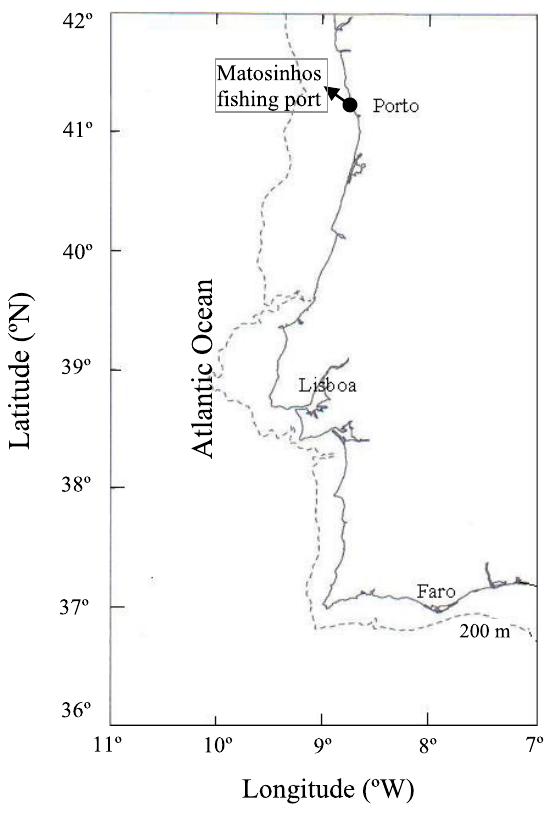
Fig. 1. Geographic location of Matosinhos, the fi shing port where samples of Trachurus picturatus were